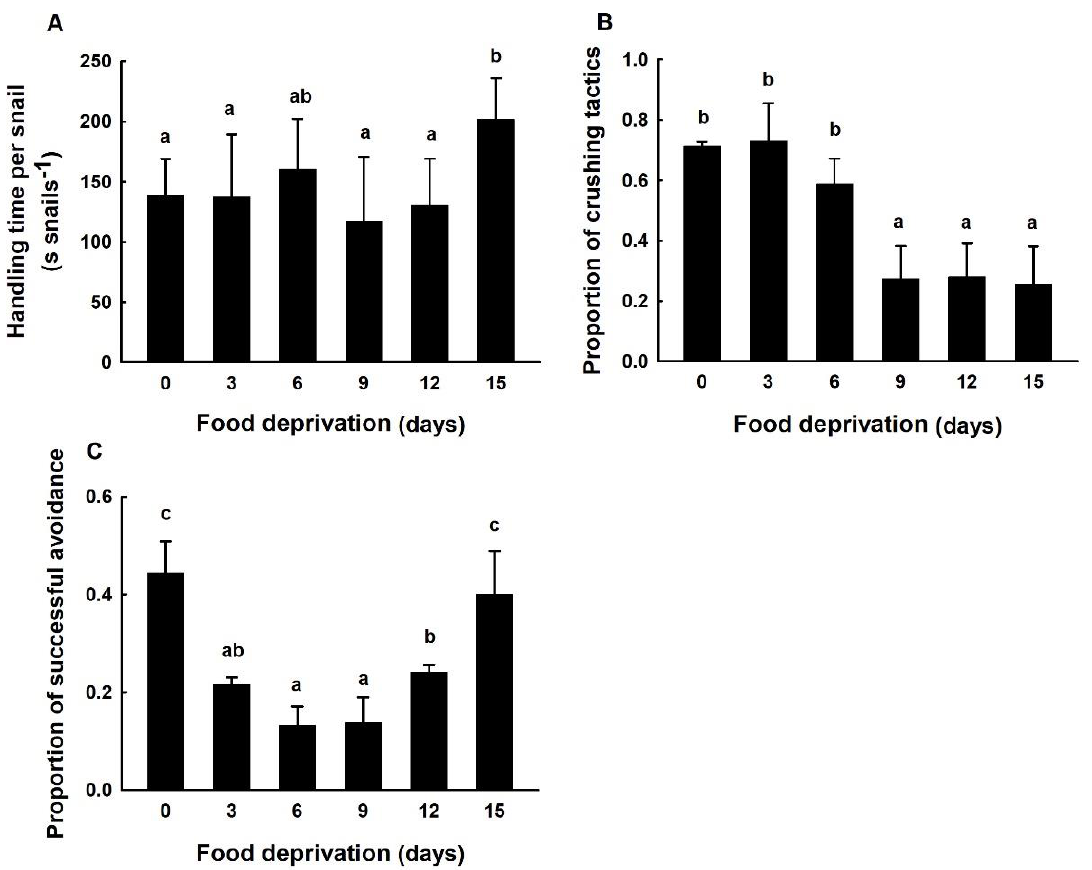
Figure 5. ( A ) The handling time per snail, ( B ) the proportion of crushing tactics, and ( C ) the proportion of successful avoidance under different degrees of food deprivation in E. sinensis . Different lowercase letters indicate significant differences among treatments ( p ≤ 0.05). E. sinensis preyed on B. quadrata using the three shell-breaking techniques (Figure 6). 232